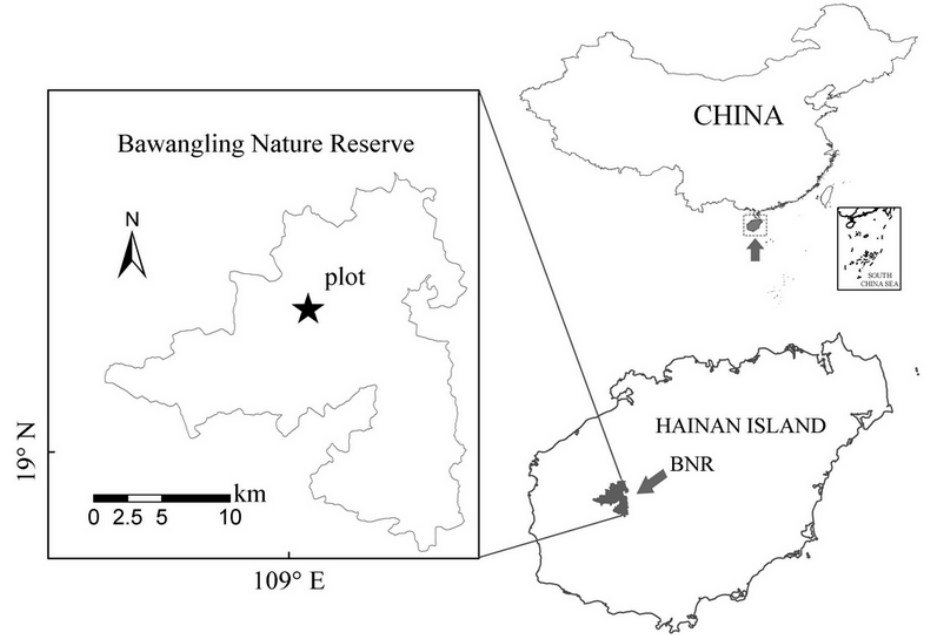
Figure 1. Location of the Bawangling Mountain and the study site.